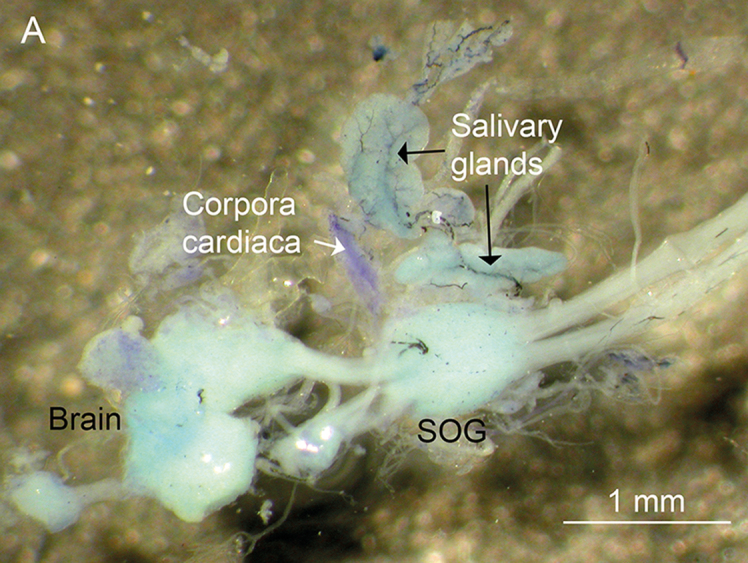
In the black field cricket (Teleogryllus commodus), one pair of salivary lobes are located on either side of the corpora cardiaca and corpora allata, connected to the thoracic salivary glands by a long narrow duct. We suggest that this might be one way of transferring hormones from the retrocerebral complex directly into the thoracic region.